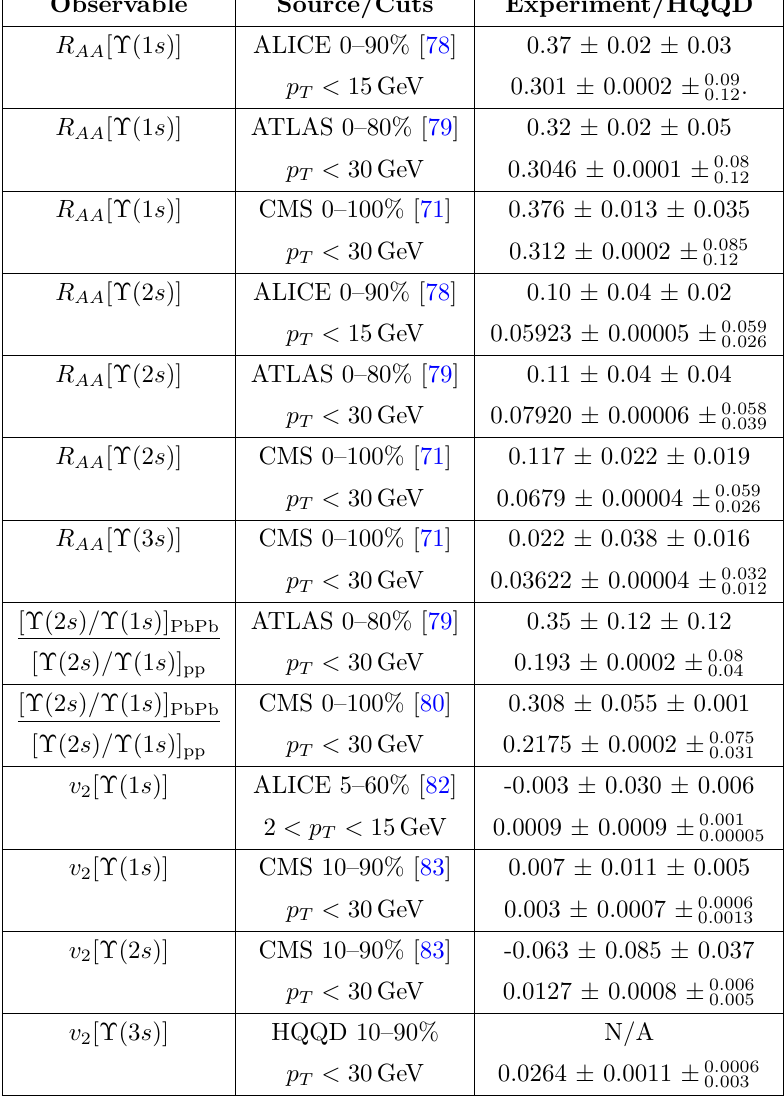
Table 4 . Comparison of HQQD predictions for integrated R AA [Υ] and v 2 [Υ] with available experi- mental data. In each row, the first column indicates the observable, the second column indicates the source of the experimental result and relevant cuts, and the third column shows the experimental result on the first line and the HQQD prediction on the second line. For both HQQD predictions and the experimental results, the first uncertainty reported is statistical uncertainty and the second is systematic uncertainty. In the case of HQQD, the systematic uncertainities were estimated by varying the HQQD model parameters in the range specified in eq.